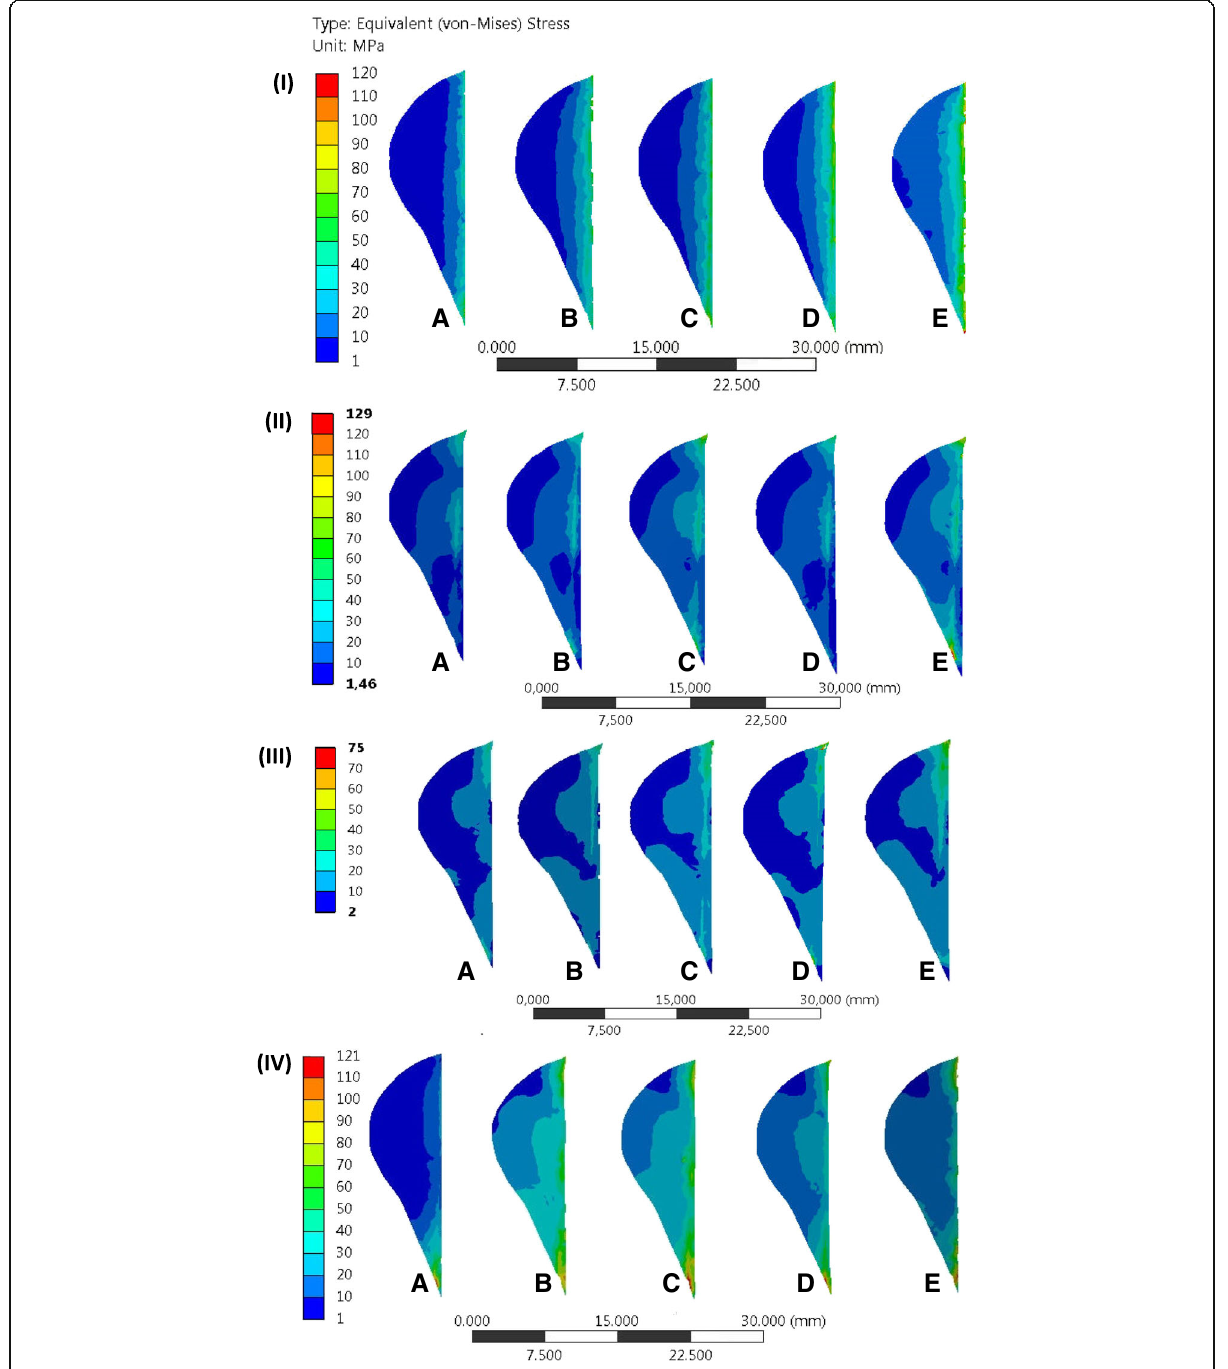
Fig. 9 Equivalent (von-Mises) stress in the contralateral cortex: ( I ) simplified loading of the tibia head. ( II ) Lower limb with muscle force loading in position 1. ( III ) Lower limb with muscle force loading in position 2. ( IV ) Lower limb with muscle force loading in position 3. The letters a, b, c, d and e indicate the iBalance, the TomoFix sm, the TomoFix std., the Contour Lock and the PEEKPower